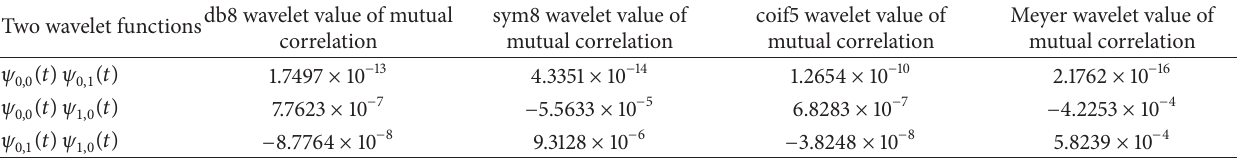
Table 1: Theoretical calculation values of mutual correlation.